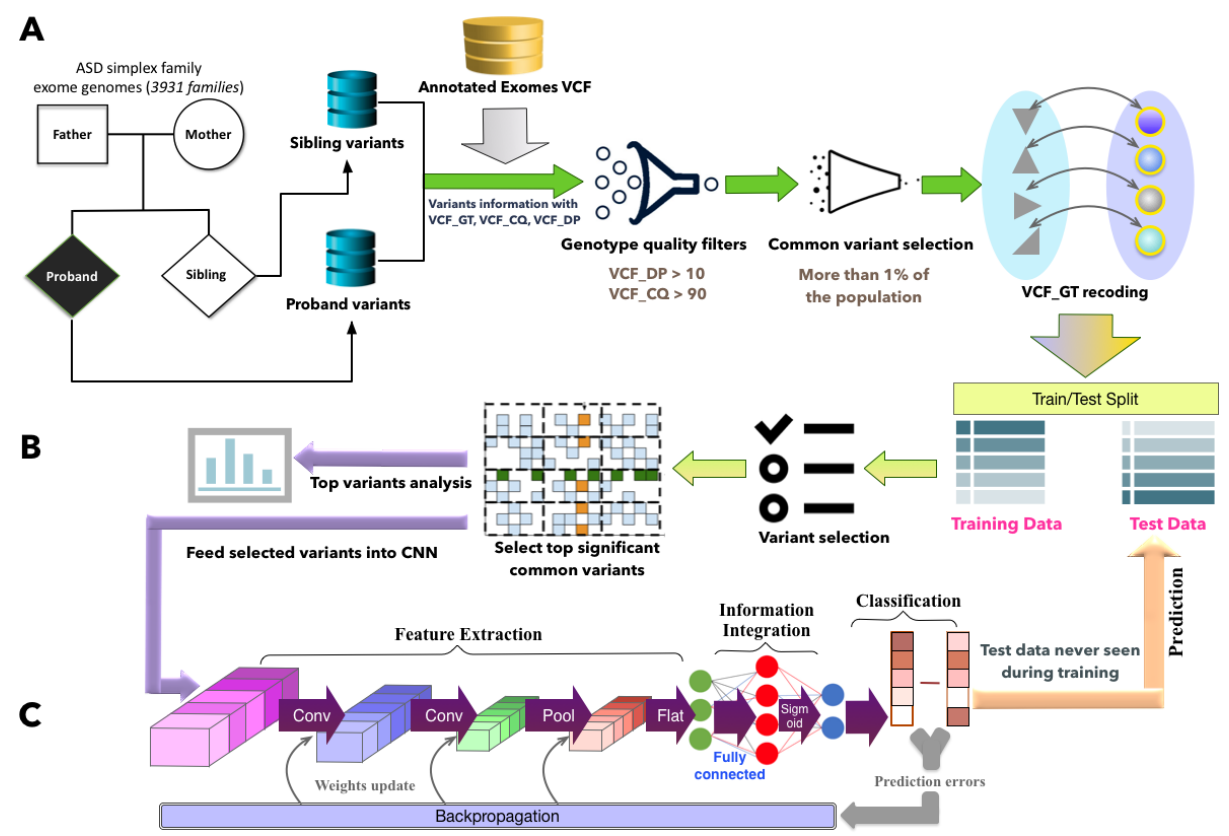
Figure 1. Overall framework for deciphering contributory common variants and predicting autism spectrum disorder diagnosis. A. Data preprocessing. VCF_GT recoding is to encode VCF_GT values as dummy variables. If both alleles are reference alleles, it is encoded as 0; if both alleles are alternate alleles, it is encoded as 2; otherwise, it is 1. B. Data split and significant variant selection. The data set was split into training set and test set. Variants were ranked based on their chi-score and P value, and only top ranked (high chi-score value and low P value) variants were selected as contributory common variants for autism spectrum disorder. C. Convolutional neural network classifier. The selected significant common variants in the training data were fed into a convolutional neural network to train a classifier. Thereafter, the trained model was applied on the test data for autism spectrum disorder diagnosis prediction. ASD: autism spectrum disorder; CNN: convolutional neural network; SSC: Simons Simplex Collection; VCF: variant call format; VCF_CQ: variant call format-conditional genotype quality; VCF_DP: variant call format-read depth; VCF_GT: variant call format-genotype